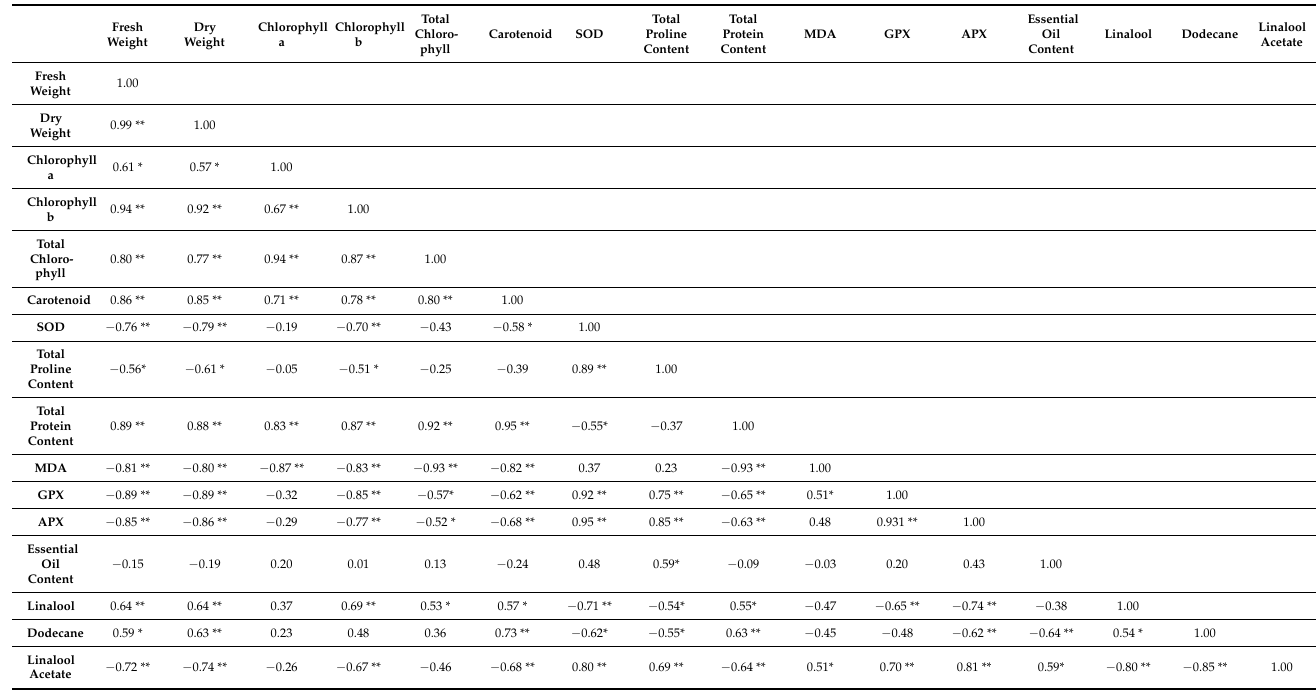
Table 3. Pearson’s correlation coefficients among grows parameters, physiological characteristics, essential oil content, and compositions of grapefruit mint under different water deficit stress and BABA